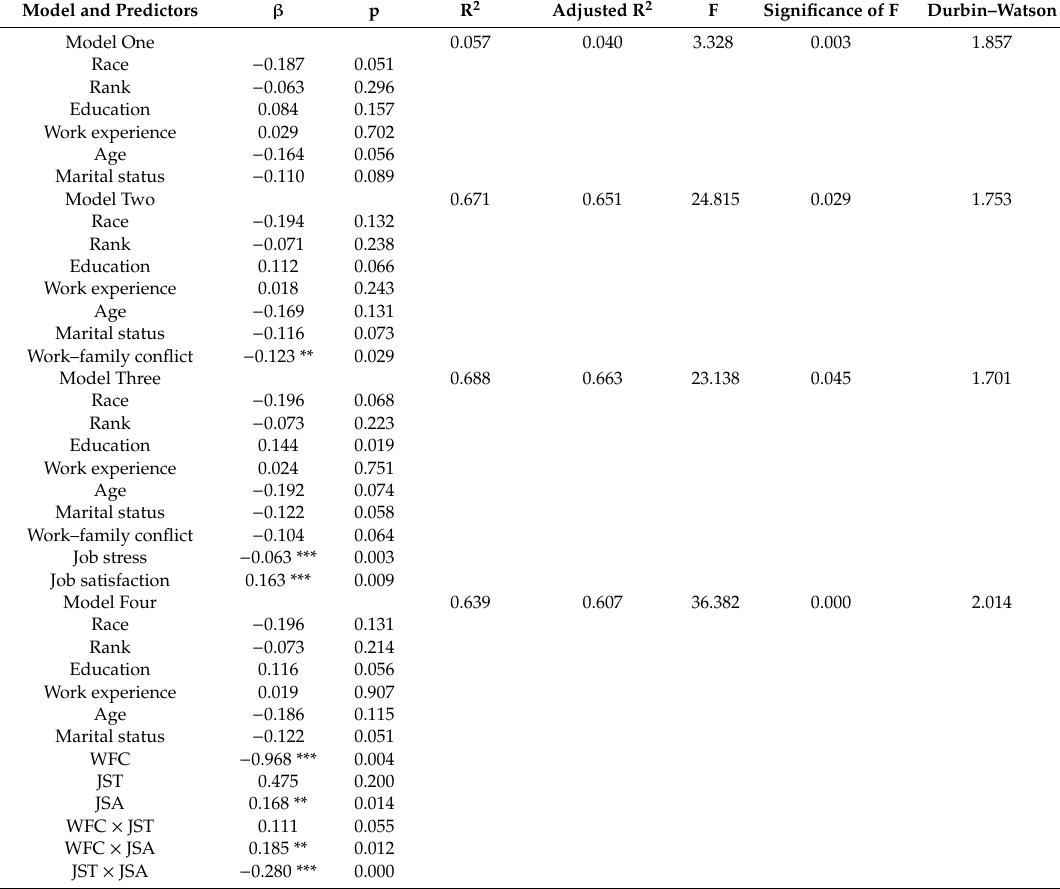
Table 4. The results of hierarchical multiple regression